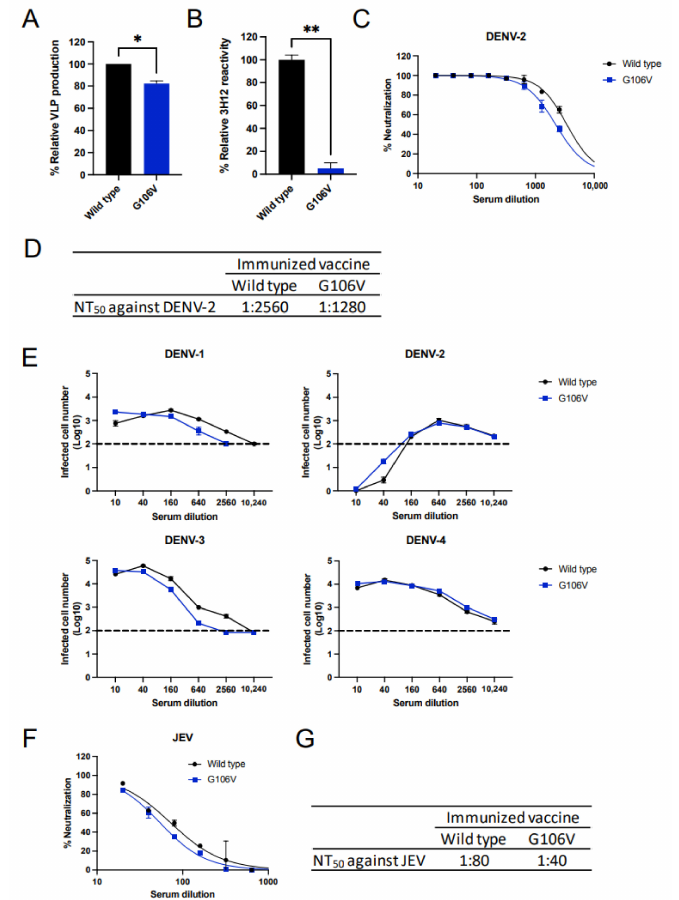
Figure 6. Effect of G106V mutation on dengue DNA vaccine. ( A ) Relative VLP production in dengue DNA vaccine-transfected cells. VLPs were produced in 293T cells transfected with DNA vaccines, which were quantified using ELISA. The VLP production was expressed as the OD of the mutant vaccine relative to that of the wild-type vaccine (OD of mutated dengue vaccine/OD of wild-type vaccine). ( B ) Reactivity of 3H12 to FL-mutated DENV VLPs. The VLPs were produced in cells transfected with mutated DNA vaccines. The reactivity of 3H12 was expressed as the OD of the mutated VLP relative to that of the wild-type VLP (OD of mutated VLP/OD of wild-type VLP). The Student’s t -test was performed to analyze the statistical significance of the comparison between the wild-type and mutant vaccines. Statistically significant values (* p < 0.05, ** p < 0.01) are represented in the graph. ( C ) Neutralizing activity against DENV-2. ( D ) NT 50 values against DENV-2. NT 50 was calculated as the maximum serum dilution yielding >50% neutralization. ( E ) ADE activity against four serotypes of DENV. Dotted lines indicate the baseline of infected cells in the control (100 infected cells; log 10 2.0). Complement was not added in this assay. ( F ) Neutralizing activity against JEV. (G) NT 50 values against JEV. NT 50 is calculated as a maximum serum dilution yielding >50%